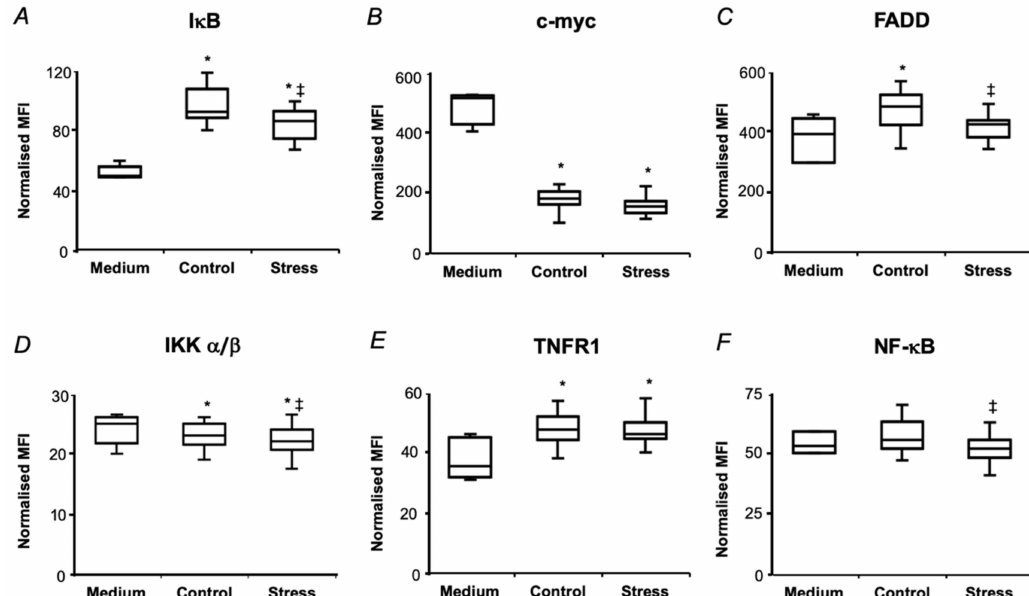
Figure 7. The e ff ects of pea seed protein hydrolyzates on the NF- κ B-mediated signaling pathway in SH-SY5Y human neuroblastoma cells. The total protein fraction was isolated from pea ( Pisum sativum L., cultivar SGE) seeds after a two-day exposure of the plants (at the seed maturation step) to the aqueous medium with and without addition of 2.5% ( w / v ) PEG 8000 (defined as Stress and Control, respectively) and subjected to exhaustive enzymatic hydrolysis. The levels of phosphorylated I κ B ( A ), c-myc ( B ), FADD ( C ), IKK α / β ( D ), TNFR1 ( E ), NF- κ B ( F ) were determined in SH-SY5Y cell